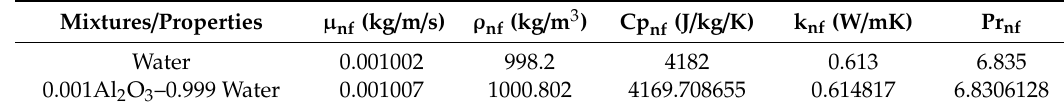
Table 1. Physical properties of the nanofluid at T = 24 ◦ C [8]. Reproduced from [8], Elsevier: 2013. Mixtures /